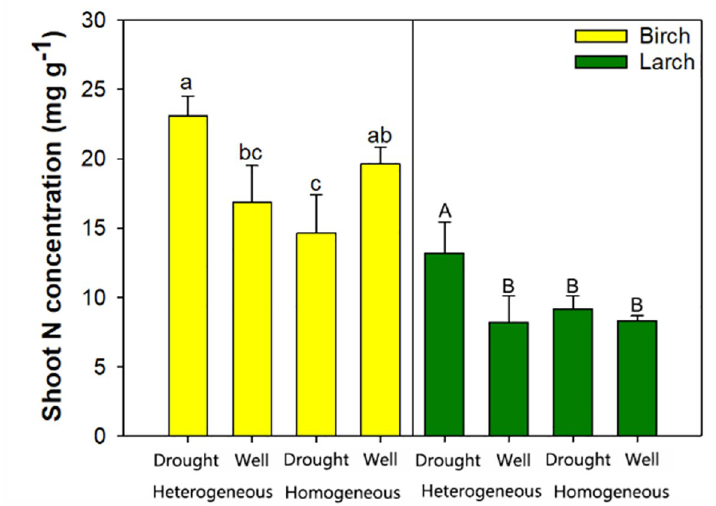
Fig 3. Nitrogen (N) concentration in shoots of birch ( Betula Platyphylla ) and larch ( Larix olgensis ) seedlings subjected to drought vs well-watered conditions in heterogeneous or homogeneous nutrient patterns. Bars indicate standard deviations. Different letters indicate significant difference of raw transformed data (see S1 Table) according to Duncan test at 0.05 level. Lower case letters stand for differences for birch seedlings and capital letters for larch